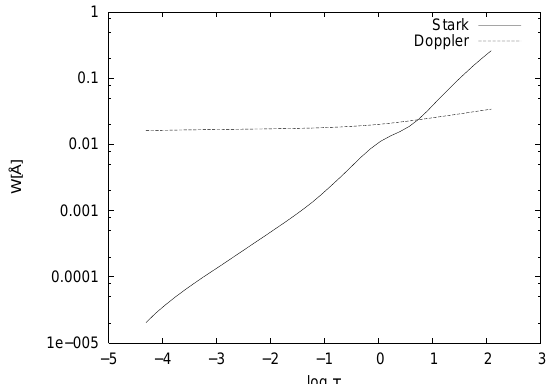
Fig. 1. Thermal Doppler and Stark widths for TeI 6s 5 S o { 7p 5 P (5125.2 (cid:23)A) multiplet as functions of Rosseland optical depth for an A-type star ( T eff = 10000 K, log g = 4.5).